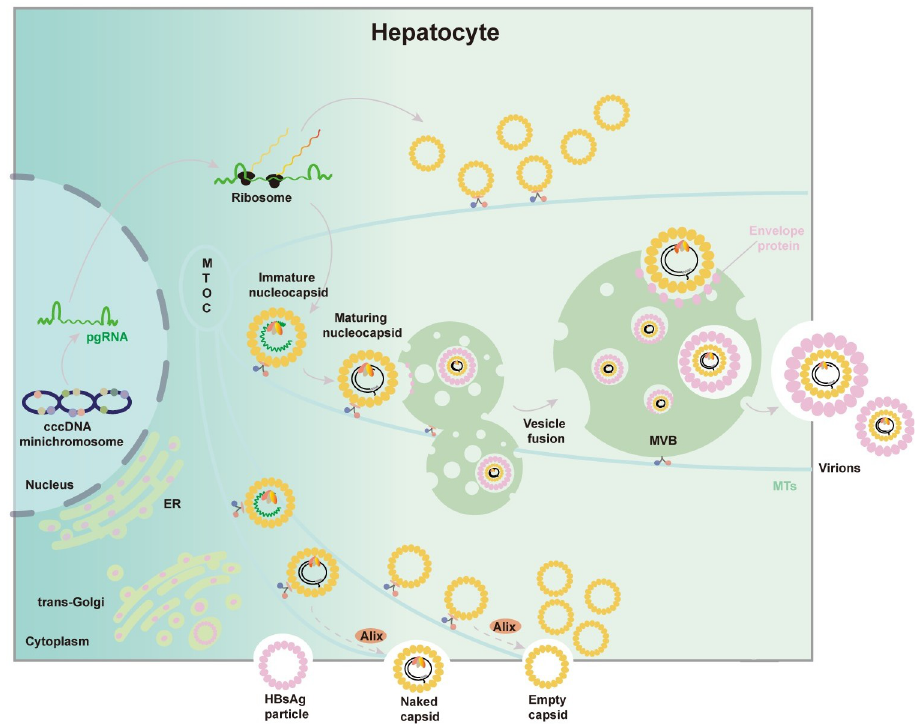
Fig 8. Schematic presentation of the molecular events from cccDNA transcription to virion morphogenesis based on the observations in this study.